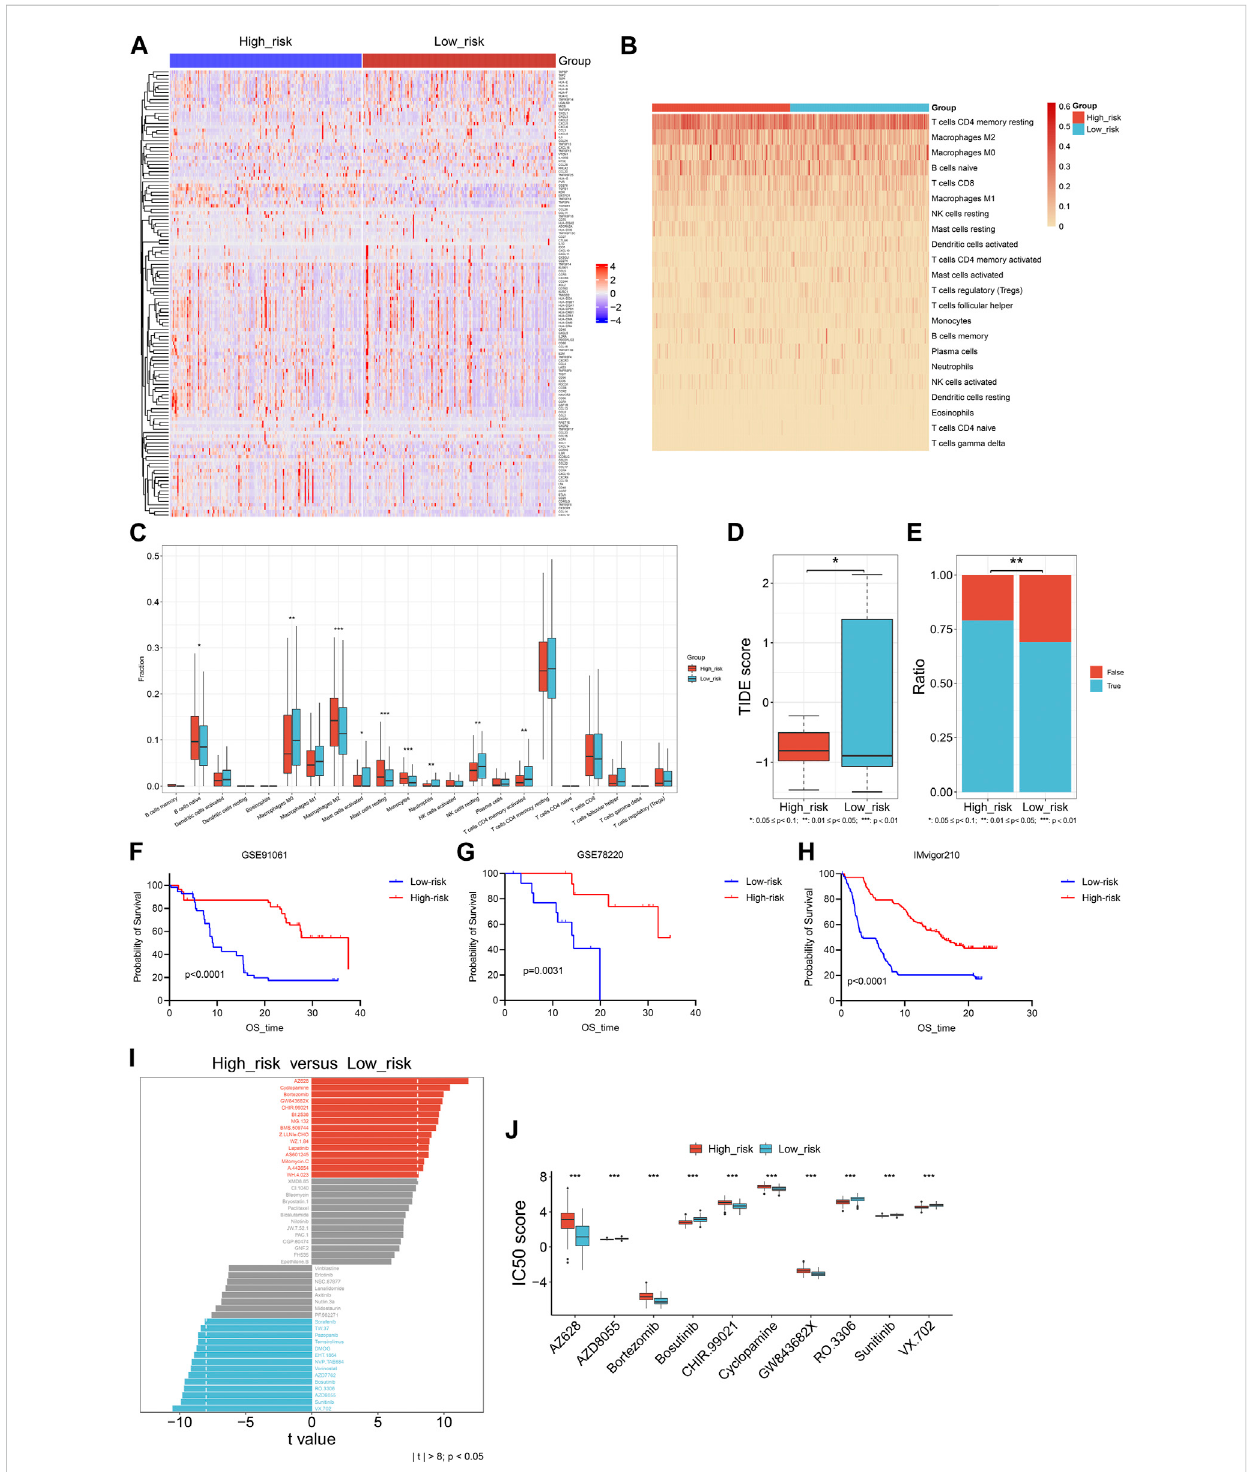
FIGURE 8 Relationships of the DNA damage repair-relevant signature with tumor microenvironment, immunotherapeutic response together with drug sensitivity across TCGA-STAD. (A) The transcriptional levels of immunomodulators in the low- and high-risk samples. Colors from blue to red represent low to high expression values of immunomodulators. (B) The distribution of the relative fractions of 22 immune cell types across the two groups. The darker the color, the larger the relative fractions of immune cell types. (C) Comparison of the relative fractions of 22 immune cell types between groups. (D,E) Comparisons of TIDE score and proportions of responders to immunotherapy between groups. (F – H) Prognostic differences of low- and high-risk patients in three immunotherapy cohorts: GSE91061, GSE78220 and IMvigor210. (I) Comparison of drug sensitivity in high-risk group versus low-risk group. (J) Box plot of the IC50 values of drugs between